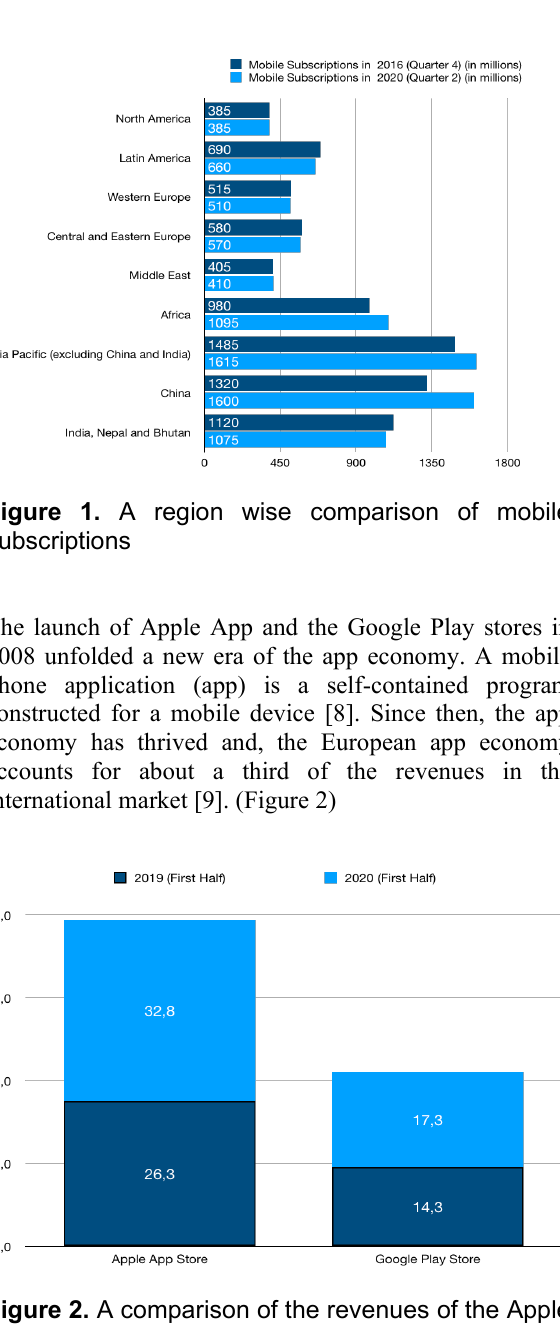
Fig ure 2. A comparison of the revenues of the Apple